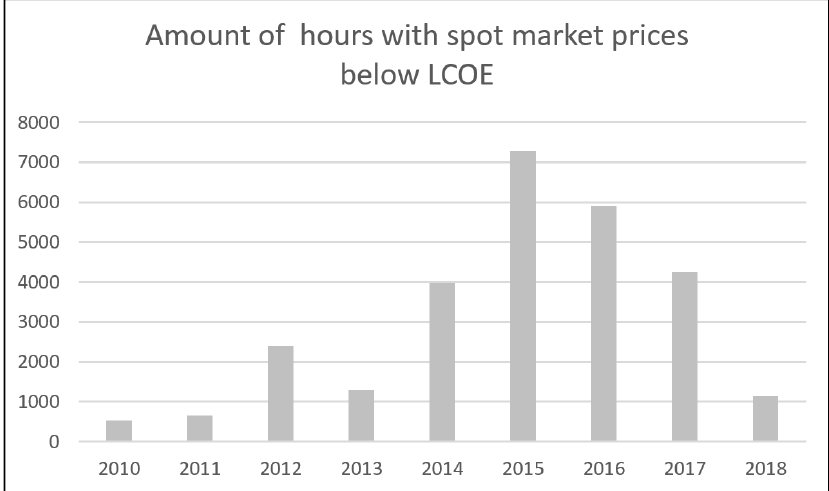
Figure 4. Number of hours per year with spot market prices below the levelised cost of wind power in DK1. Based on data from [61]. LCOE: Levelised cost of energy.